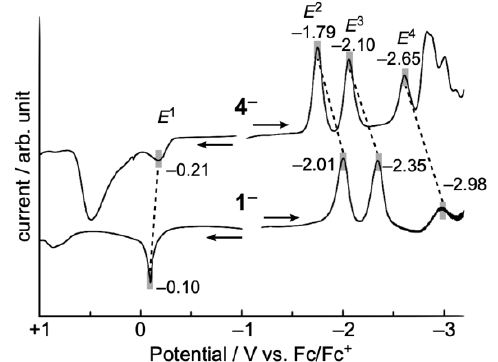
Figure 2. Differential pulse voltammetry (DPV) of 1 and 4 in DMF solution. The results were calibrated with the ferrocene/ferrocenium couple (Fc/Fc + ). Due to poor solubility, corresponding monoanion salts, [( n -Bu) 4 N + ]( 1 − ) and [( n -Hex) 4 N + ]( 4 − ), respectively, were used for the measurements. The waves observed at the higher potential than E 1 and lower potential than E 4 would be derived from the aggregates or decomposition of the corresponding products, because they were irreversible by cyclic voltammetry (Figure S2).